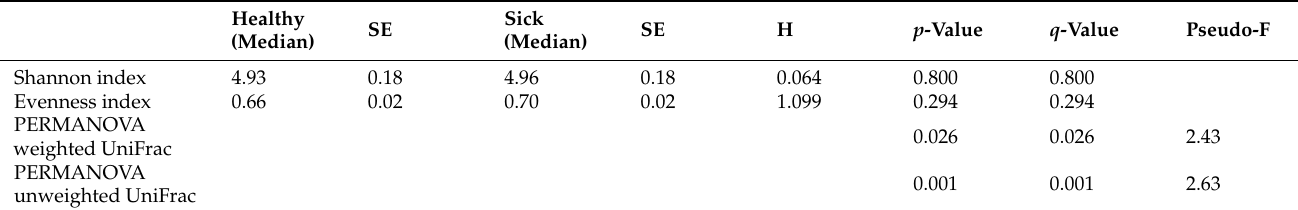
Figure 4. Alpha diversity, shown as the median of the Shannon index ( A ) and the Evenness index ( B ) in fecal samples of healthy and sick dogs. Table 4. Non-parametric Kruskal–Wallis test of the Shannon and the Evenness alpha diversity indexes, and PERMANOVA analysis of the weighted and unweighted UniFrac dissimilarity matrix on the fecal microbiome of healthy and sick dogs. p -value below 0.05 denoted